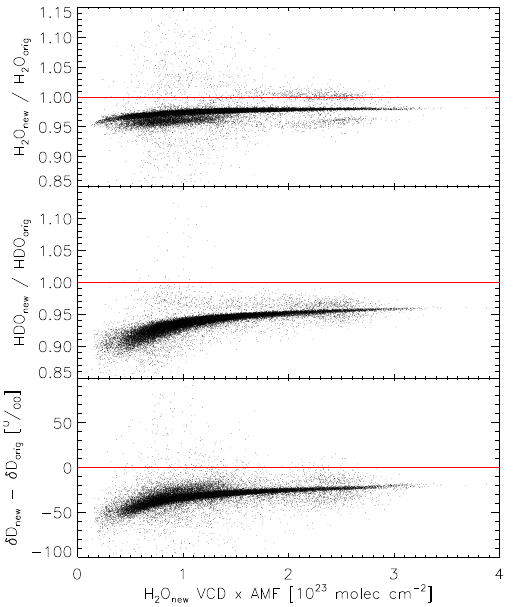
Fig. 8. Top: ratio between all the retrieved vertical column densi- ties (VCDs) for SCIAMACHY in June 2003 of H 2 O using the up- dated spectroscopy (“new”) and the original spectroscopy (“orig”). Plotted as a function of the H 2 O VCD multiplied by the air mass factor (AMF), which is a good metric for the total amount of wa- ter vapour as seen by the detector. The updated spectroscopy leads to a reduction of the H 2 O columns of ∼ 2–5% for the majority of the ground pixels. Middle: same for the retrieved HDO VCD. The updated spectroscopy leads to a reduction of the HDO columns of ∼ 4–10% for the majority of the ground pixels and the reduction increases for the driest columns. Bottom: shift in δ D corresponding to the top two panels. The updated spectroscopy leads to a negative shift of ∼ 25‰ for the majority of the ground pixels and this shift becomes larger for the driest